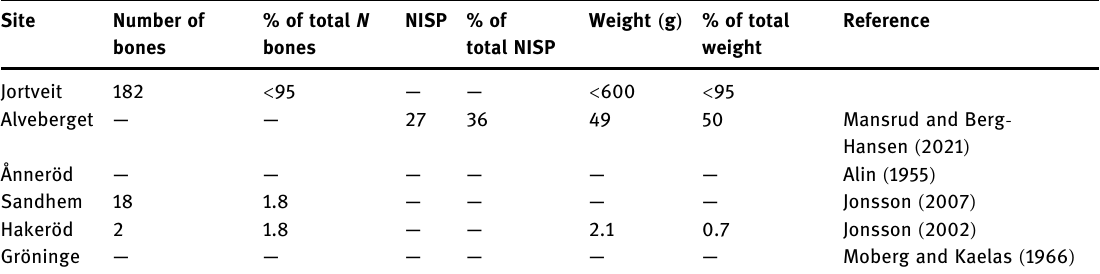
Table 1: Quantitative overview of Blue fi n tuna bones from Early and Middle Neolithic sites located along the Skagerrak and Kattegat coast in Norway and Sweden ( NISP: Number of identi fi ed specimen